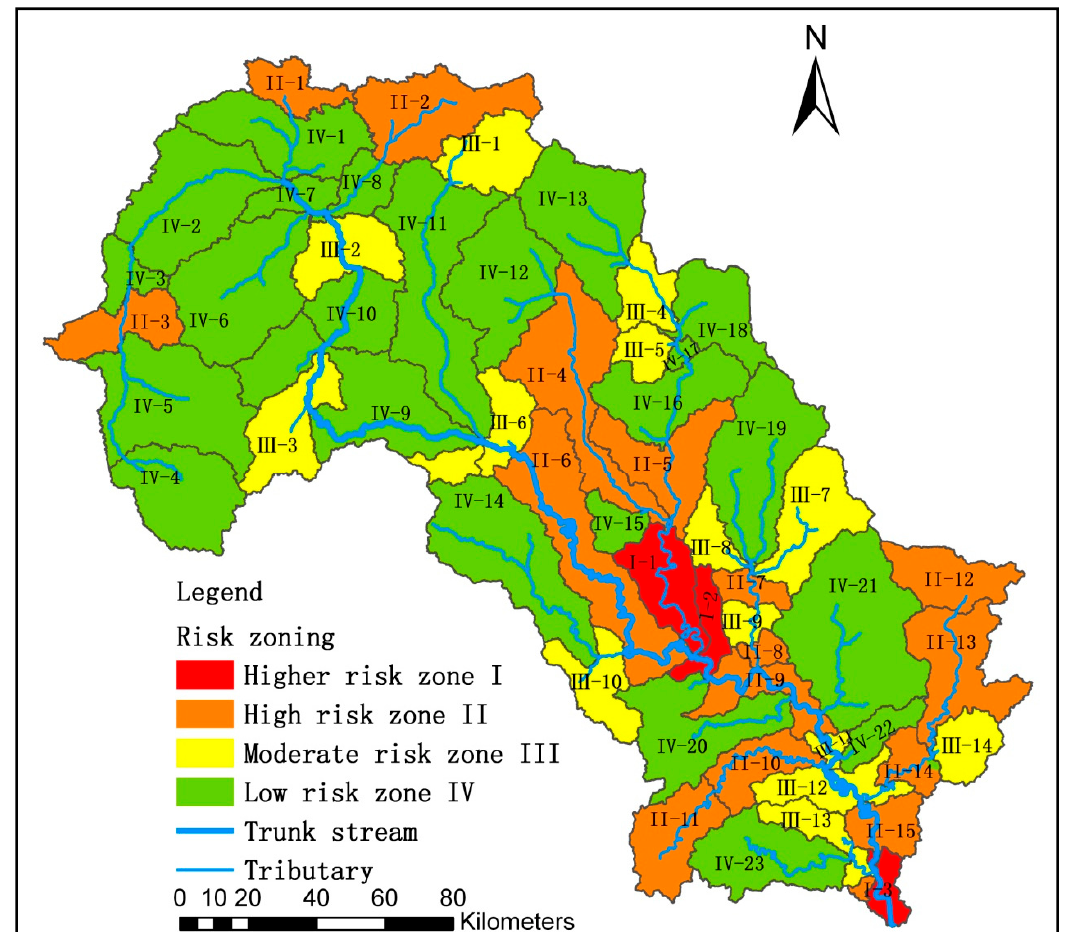
Figure 12. Risk zoning in the upper-middle reaches of Luanhe River based on water function area.